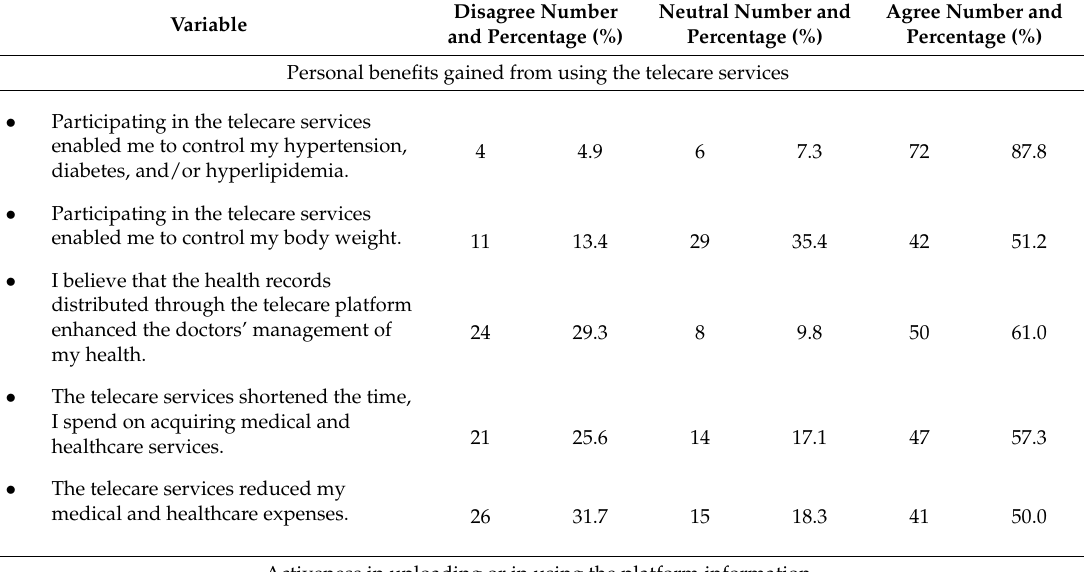
Table 2. The IUT of the participants (N =